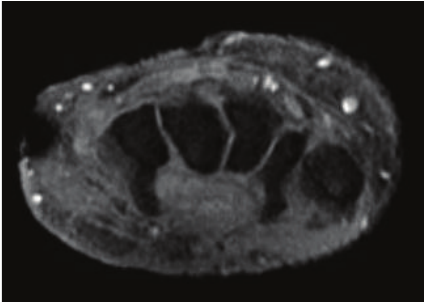
Figure2:MRIoftheleftarmshowedmultipleulcerationsextending from skin into subcutaneous fat with appearance concern for necrotizing fasciitis and osteomyelitis.